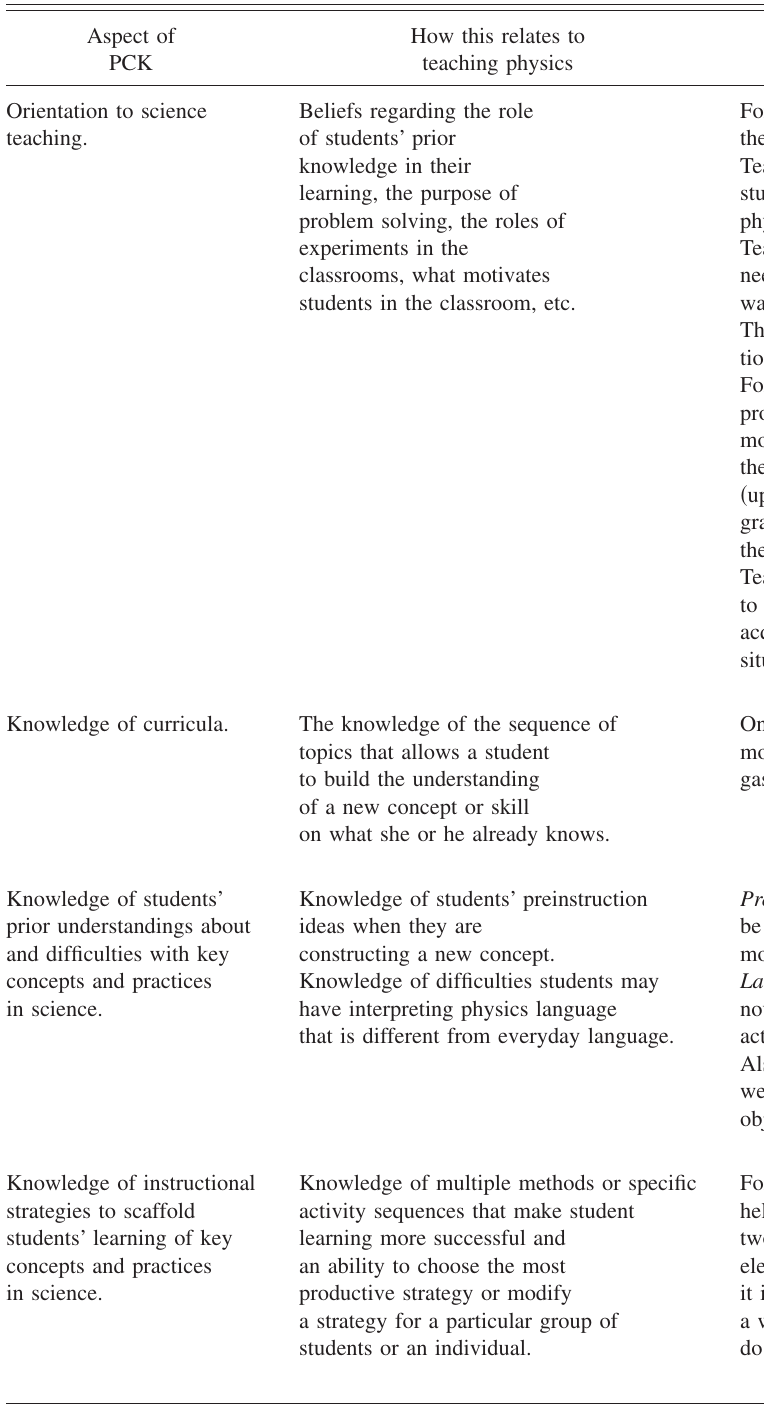
TABLE I. Five aspects of PCK and their relationship to teaching